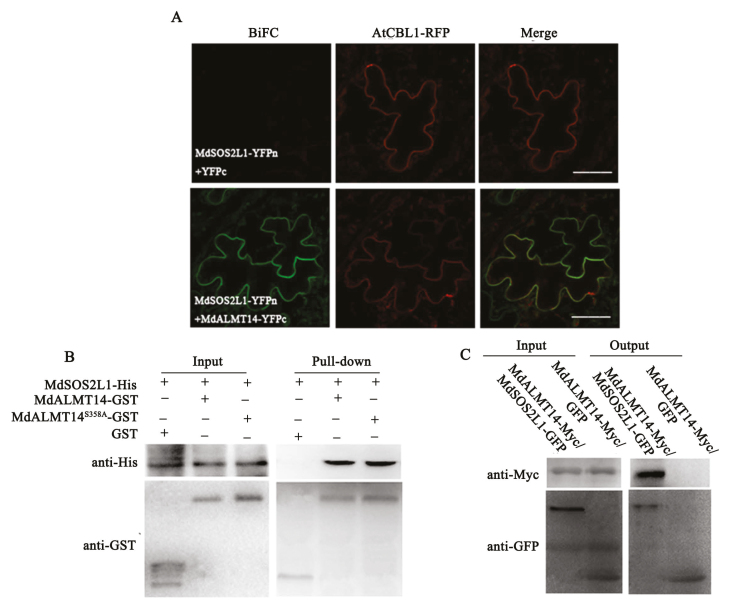
MdSOS2L1 interacted with MdALMT14. (A) BiFC was conducted in Nicotiana benthamiana to test the interaction between MdSOS2L1 and MdALMT14, with a plasma membrane marker (AtCBL1–red fluorescent protein (RFP)) included. (Scale bars: 100 µm.) (B) In vitro GST pull-down assays. MdSOS2L1–His proteins were incubated with immobilized MdALMT14–GST or GST, and the proteins immunoprecipitated with GST-beads were detected using anti-His antibody. (C) In vivo Co-IP assays between MdSOS2L1 and MdALMT14. Proteins were extracted from 35S::MdALMT14-Myc+35S::MdSOS2L1-GFP or 35S::MdALMT14-Myc+35S::GFP co-expressed in apple calli and immunoprecipitated with an anti-GFP antibody. The proteins from crude lysates (input) and the immunoprecipitated proteins (output) were detected with an anti-Myc antibody and anti-GFP antibody.